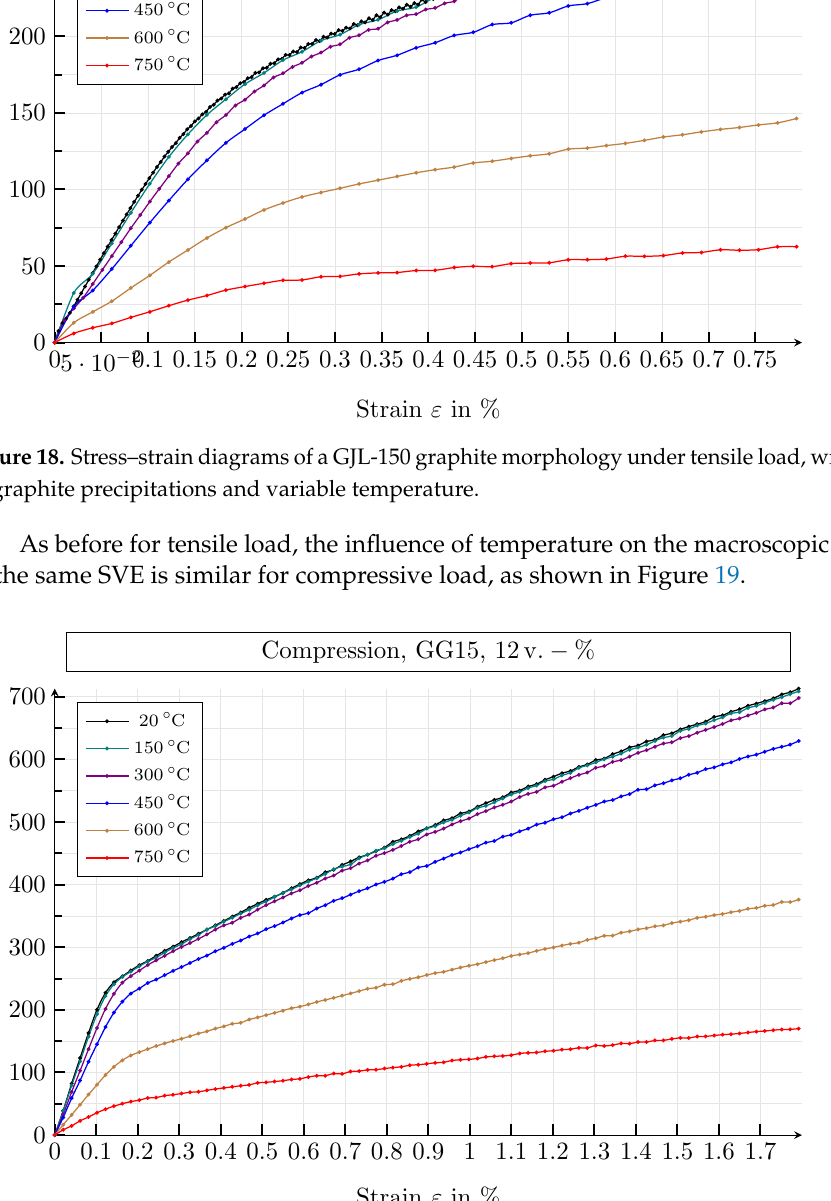
Figure 19. Stress–strain diagrams of a GJL-150 graphite morphology under compressive load, with 12v. % of graphite precipitations and variable temperature. The stress–strain curves are given − by positive